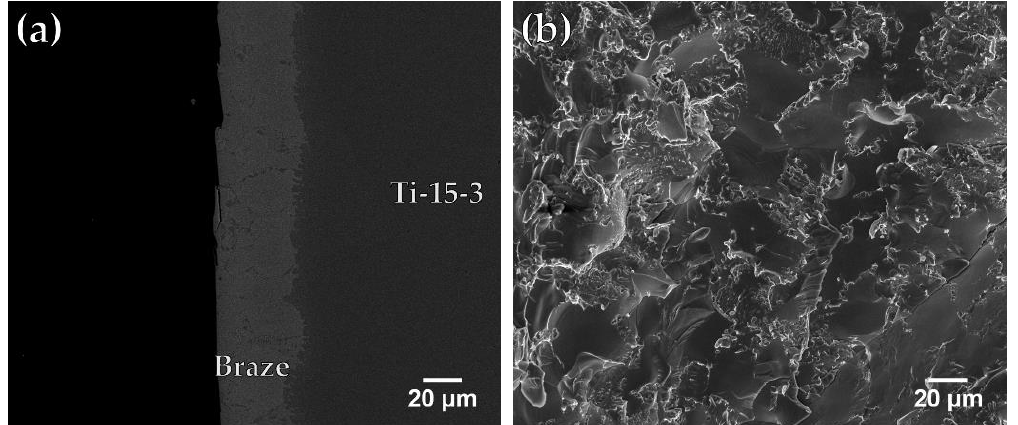
Figure 9. FESEM ( a ) BEI cross section and ( b ) SEI fractograph of Ti-15-3/Ticusil ® /Ti 50 Ni 50 joint brazed at 950 °C for 300 s after shear test.